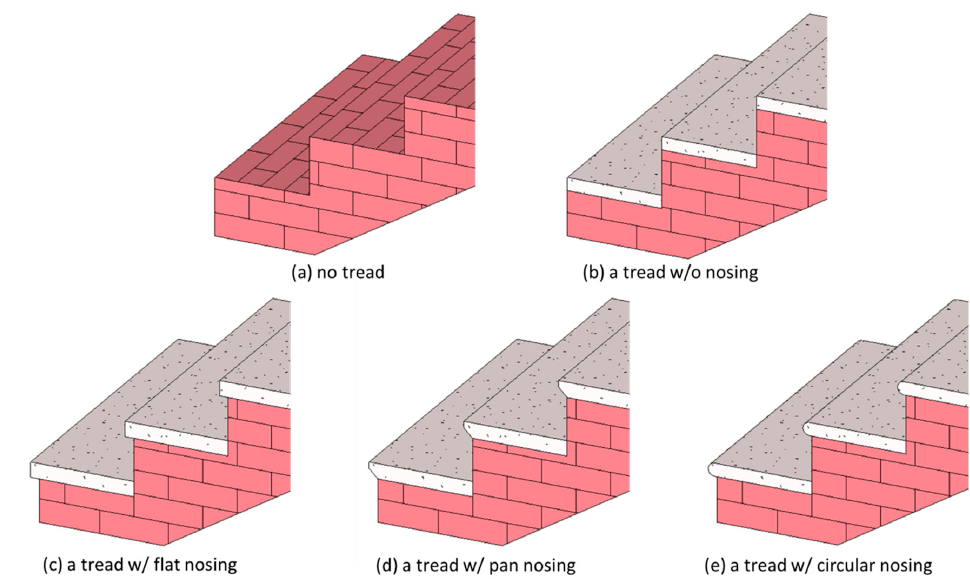
Figure 7. Treads with various nosing profiles.